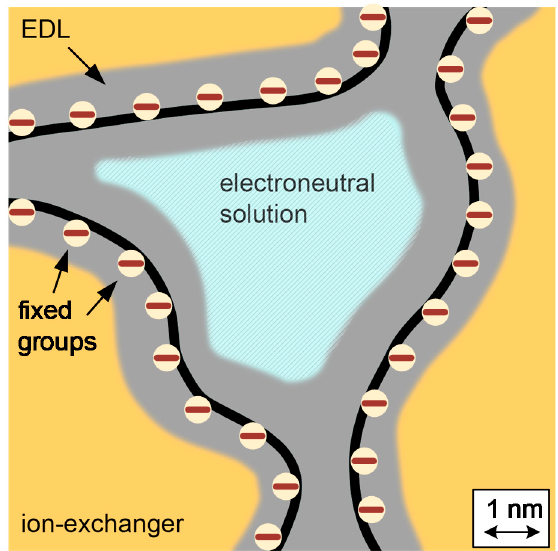
Figure 2. The schematic depiction of the ion-exchange membrane microstructure.